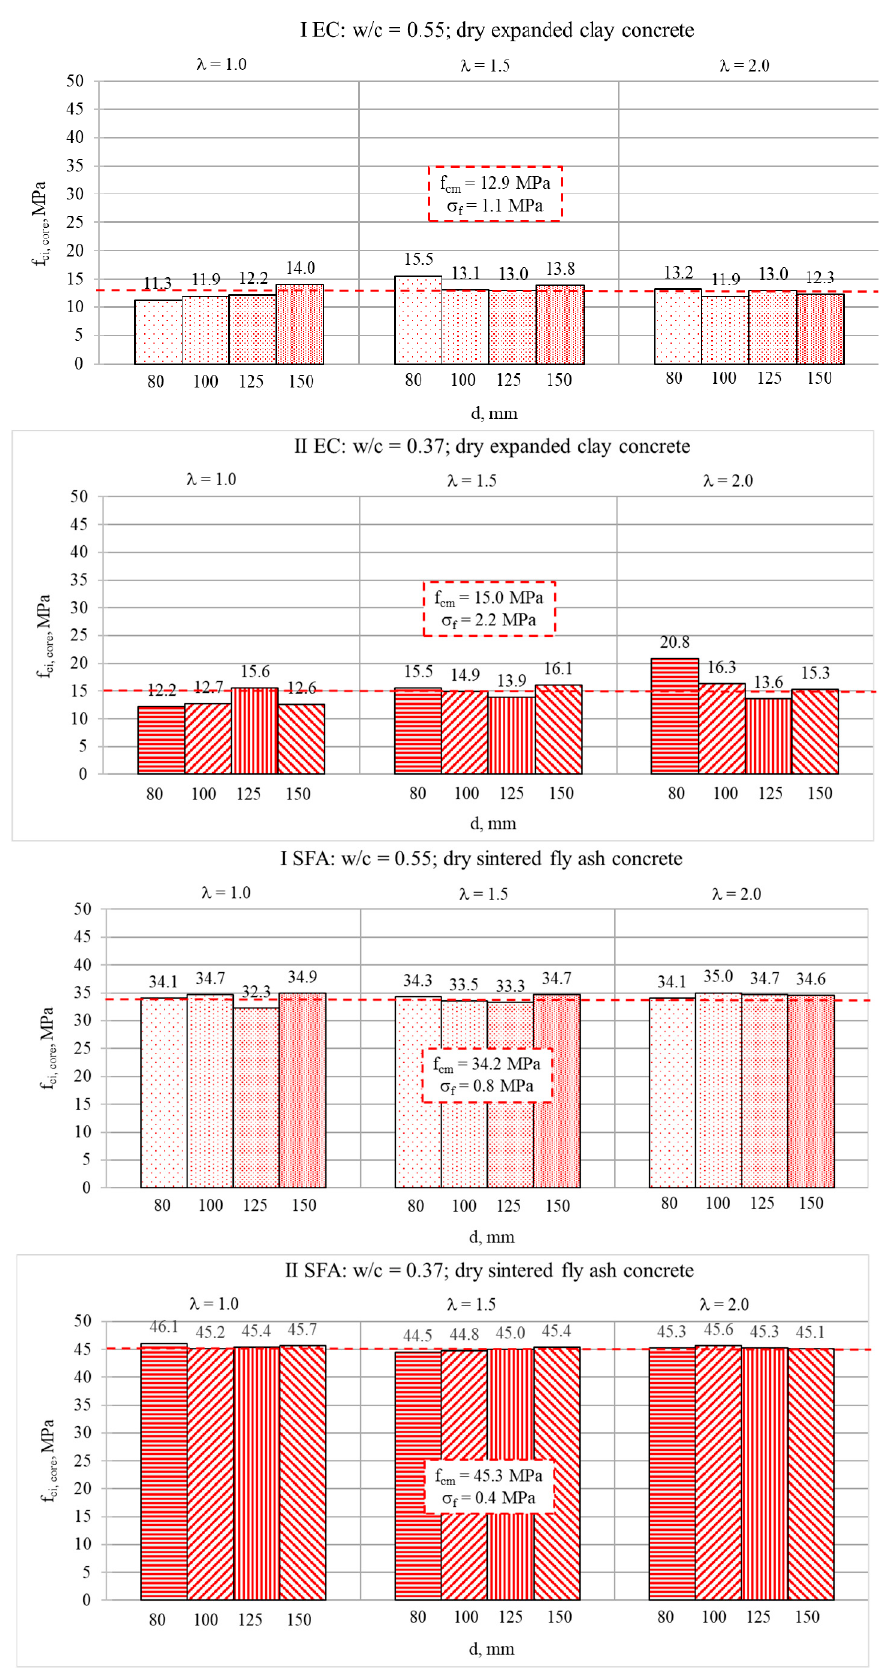
Figure 5. Mean values of compressive strength determined for moist cored specimens of various diameters d and slenderness λ .